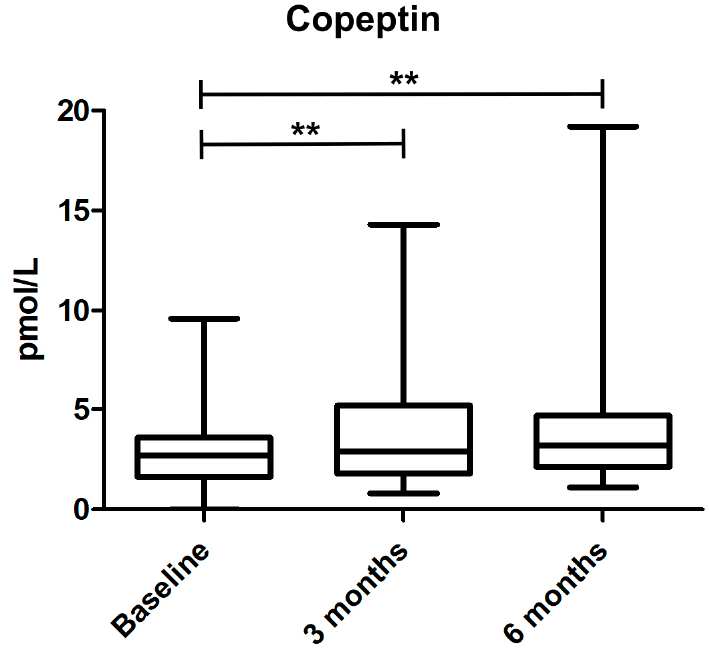
Figure 2. Copeptin levels over time. Box plots with interquartile range of copeptin levels at baseline and 3 and 6 months follow up. ** indicates significance p < 0.01.